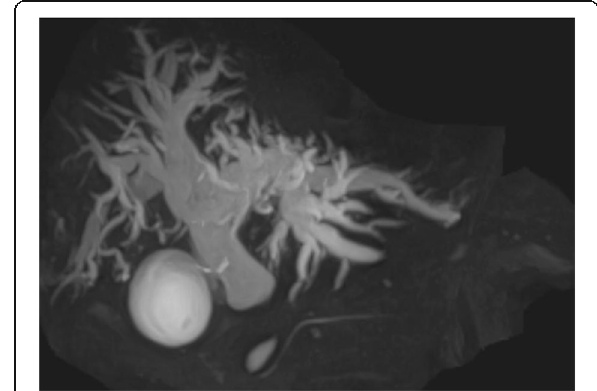
Fig. 1 Magnetic resonance cholangiopancreatography showing stenosis of the lower bile duct